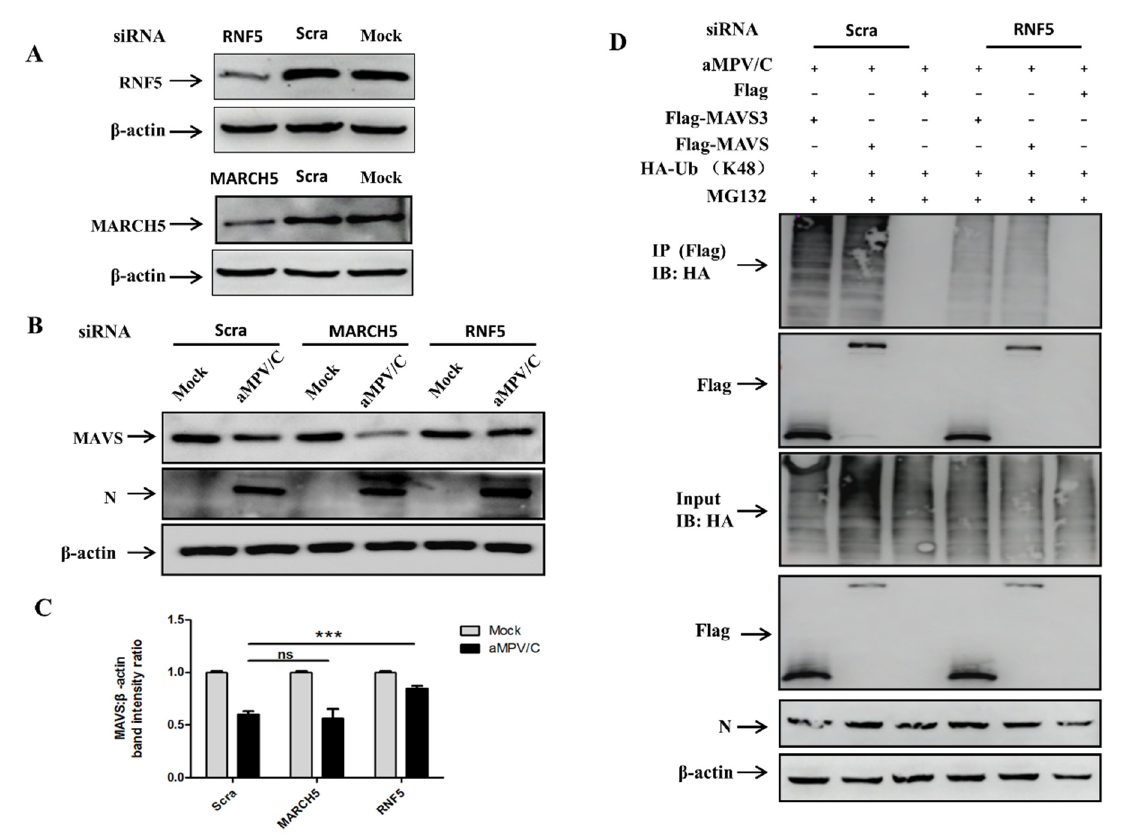
Figure 6. E3 ubiquitin ligases for MAVS degradation are screened and identified in aMPV/C-infected Vero cells. ( A ) Vero cells were transfected with 40 pmol MARCH5-siRNA (MARCH5), RNF5-siRNA (RNF5), and scrambled-siRNA (Scra) and were detected at 48 h by Western blotting with anti-MARCH5, -RNF5, or β -actin antibody. ( B ) Vero cells were transfected with 40 pmol MARCH5-siRNA (MARCH5), RNF5-siRNA (RNF5), or scrambled-siRNA (Scra) and then were infected with aMPV/C for 48 h. Cells were harvested and analyzed using Western blotting with anti-MAVS, anti-N, or anti- β -actin antibody. ( C ) Representative results are displayed with graphs corresponding to the ratios of MAVS: β -actin normalized to the control conditions. ( D ) 40 pmol RNF5-siRNA (RNF5), or scrambled-siRNA (Scra) transfected Vero cells were co-transfected with Flag, Flag-MAVS3, or Flag-MAVS and HA-Ub. The cells were infected with aMPV/C and analyzed as described in A. Error bars represent mean ± SD of three independent experiments. ns (not significant) p > 0.05; *** p < 0.001, compared with the Scra group.